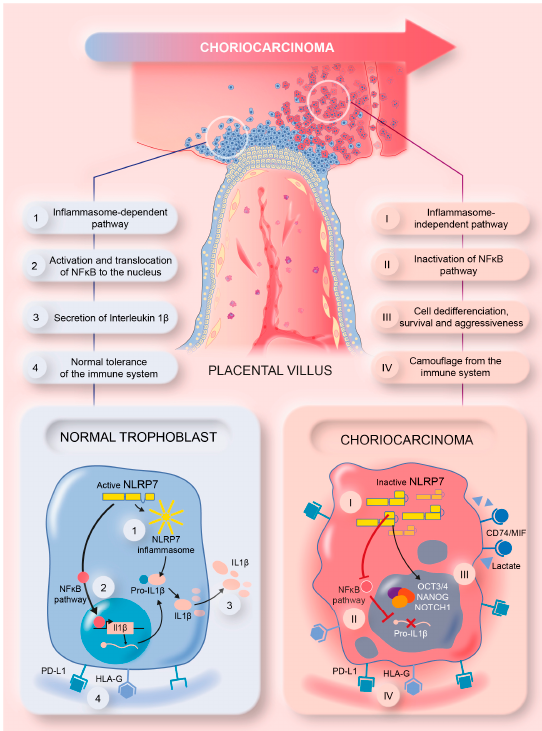
Figure 8. A summary model illustrating the mechanism by which NLRP7 contributes to choriocar- cinoma tumorigenesis.